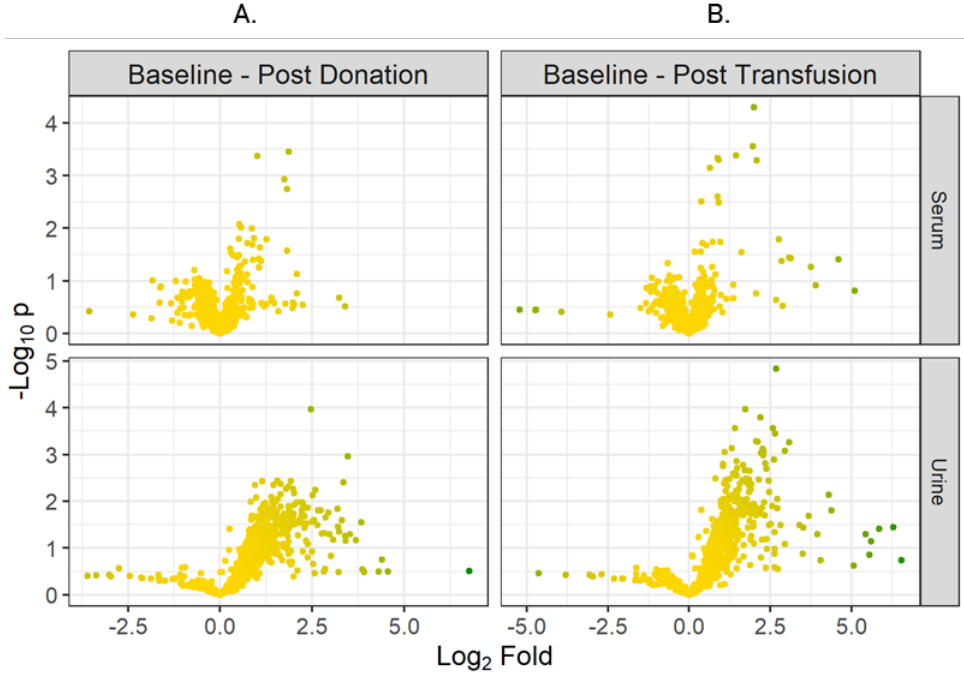
Figure 1. Volcano Plots ( A ) comparing Baseline vs. Post-donation in serum and urine, ( B ) comparing Baseline vs. Post-transfusion in serum and urine.